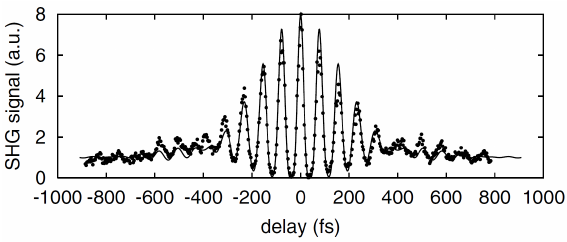
Figure 5. Result of autocorrelation measurement with fringe-resolved SHG signal at the JAERI-FEL (dots). The solid line is a fitted curve by the chirped-sech 2 pulse